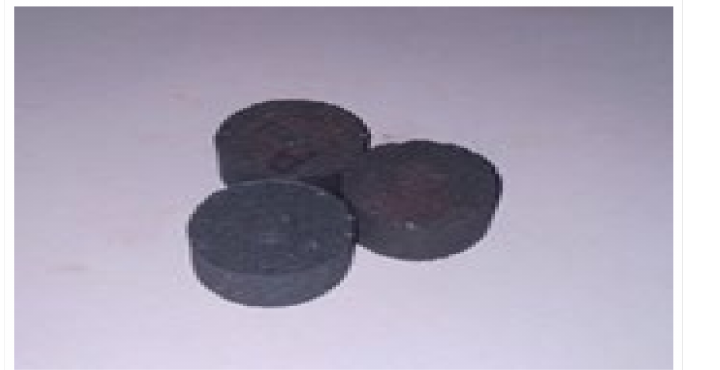
Figure 9. Preforms heated in microwave